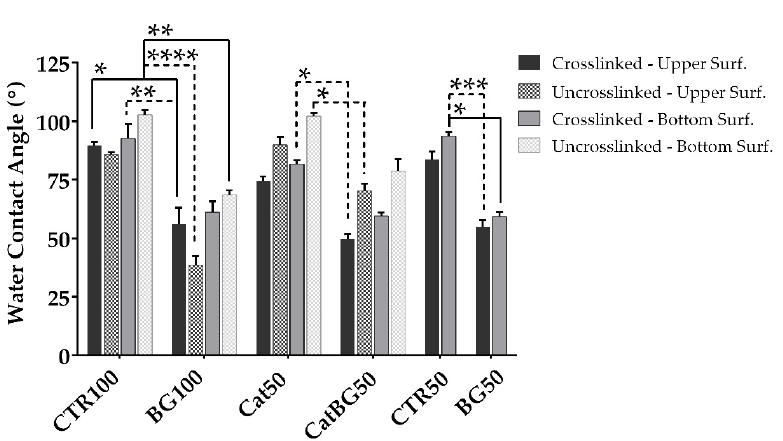
Figure 9. Water contact angle (WCA) measured values of both sides of the films before (except CTR50 and BG50) and after cross-linking with genipin, being the “upper surface” HA/HAcat and the “bottom surface” CHI/CHIcat in all film formulations. Significant differences were stated for p < 0.05 (*), p < 0.01 (**), p < 0.001 (***), and p < 0.0001 (****). Straight line represents the significant differences between equivalent surfaces and in dotted lines those between opposite surfaces (i.e., upper-bottom).